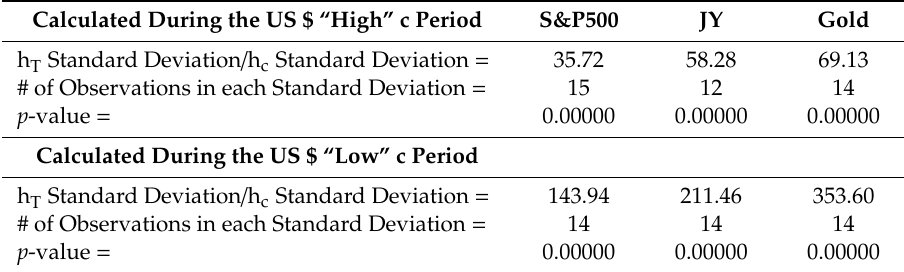
Table A2. Ratio of the HRs’ Standard Deviations (HRs based on US $s).